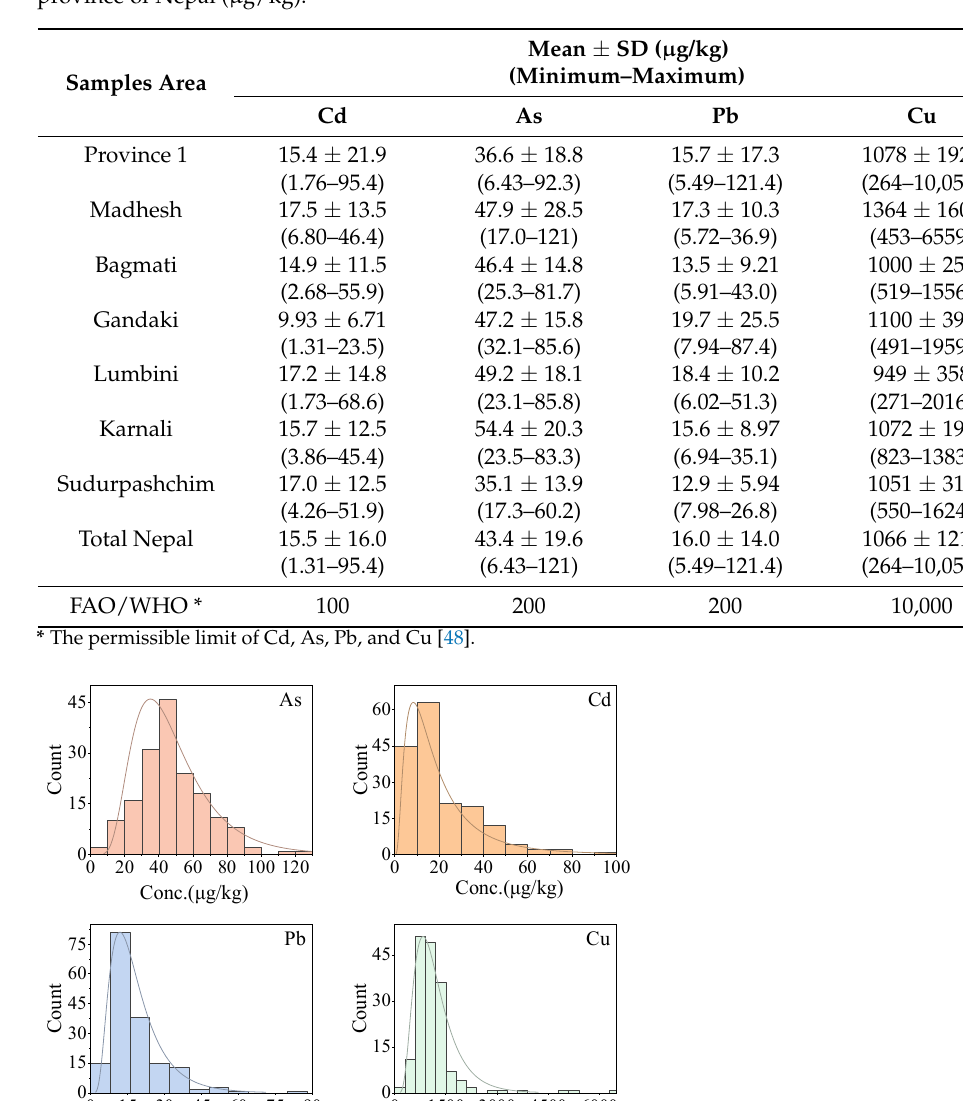
Table 1. Concentrations of Cd, As, Pb, and Cu in commercial rice samples (n = 170) from each province of Nepal ( µ g/kg).